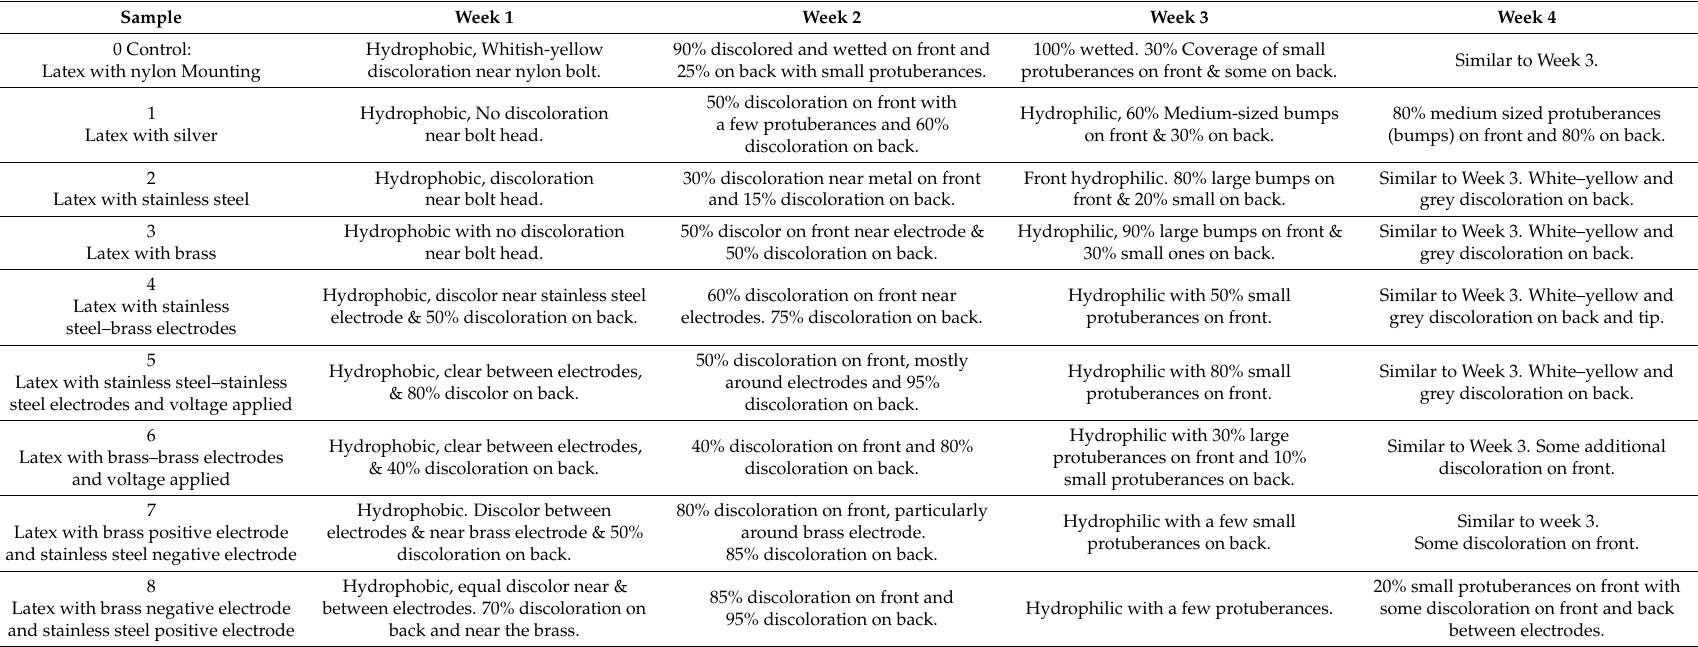
Table 1. Summary of Weekly Sample Appearance for Three Trials during